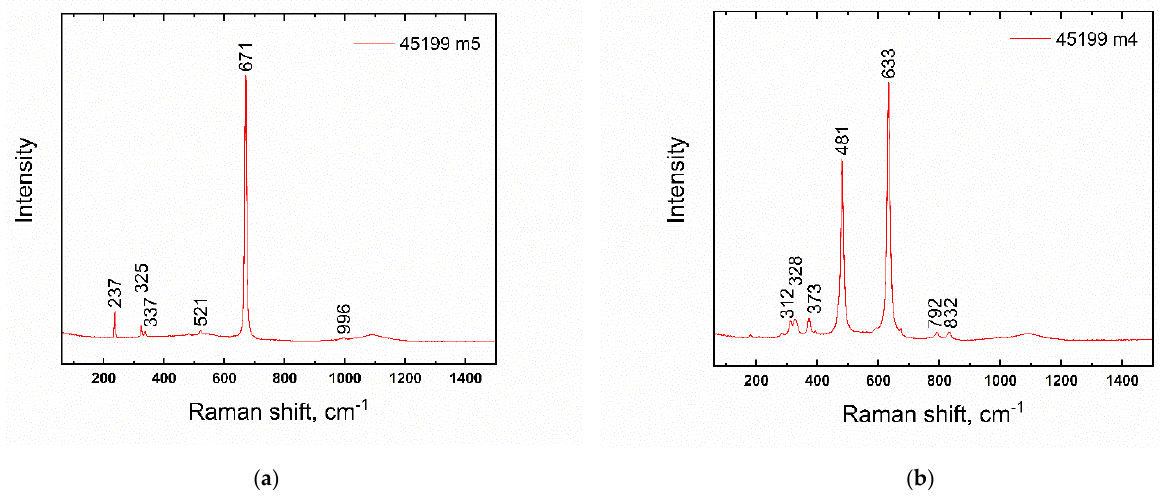
Figure 8. Raman-spectra of calcium antimonates; bead No. 21. ( a ) CaSb 2 O 6 ; ( b ) Ca 2 Sb 2 O 7 .